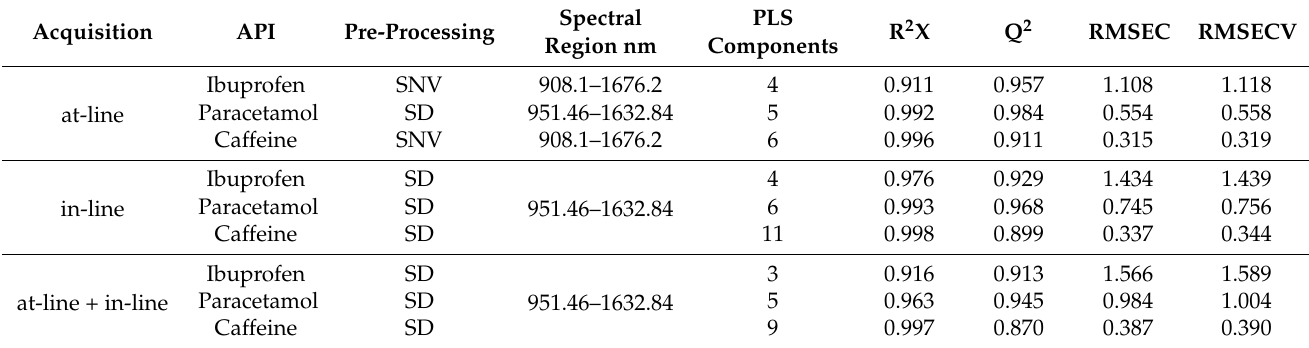
Table 1. PLS model characteristics for active ingredient quantification by MicroNIR.